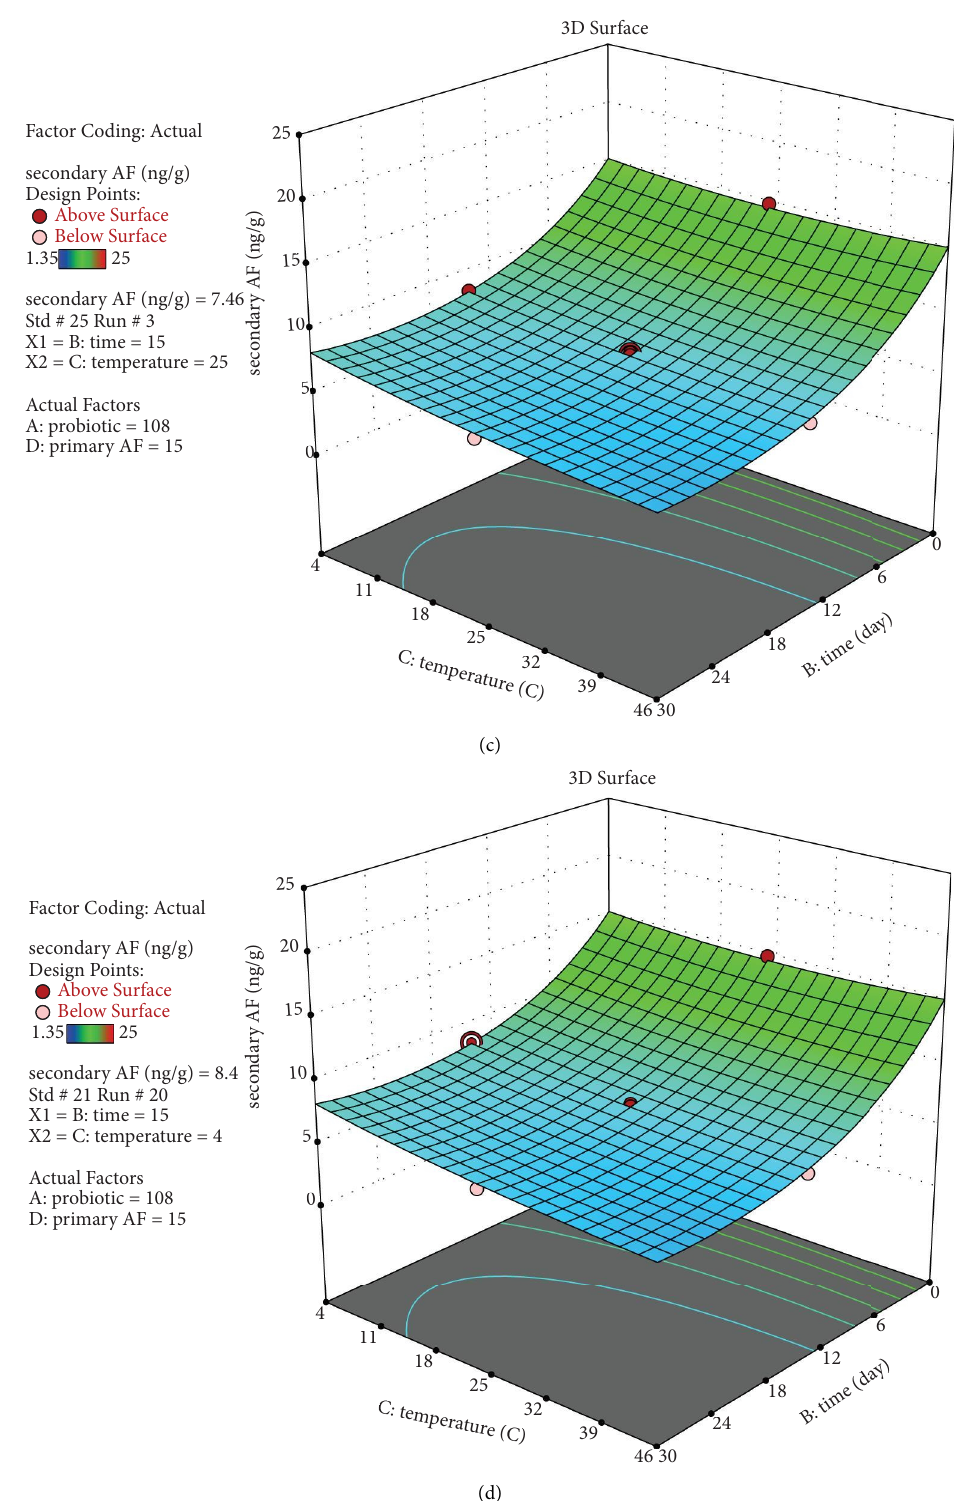
Figure 4: Interaction of probiotic content (10 8 CFU/g) and the inoculated afatoxin level (15ng/g) on the afatoxin residue in pistachio